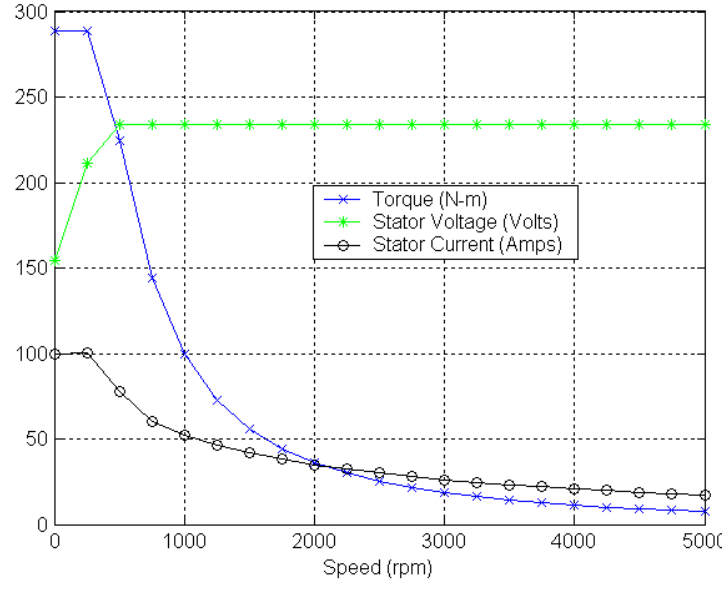
Figure 4. Torque speed characteristics of an ISA